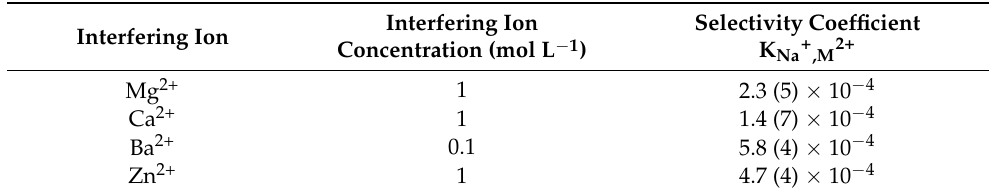
Table 2. Selectivity coefficients of Na + -ISE based on (NaI) 15 (Ga 2 S 3 ) 23 (GeS 2 ) 62 glass membrane with respect to the interfering ions Mg 2+ , Ca 2+ , Ba 2+ and Zn 2+ . The measurements were conducted using a constant concentration of interfering ions 1 .